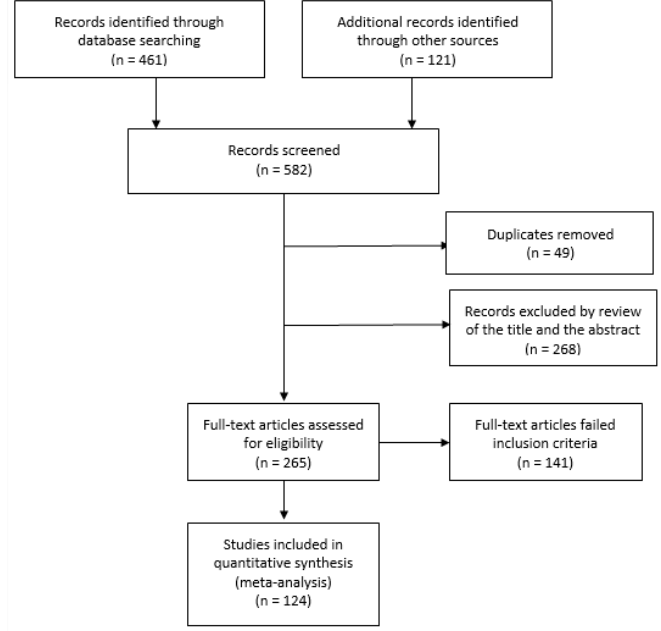
Figure 3. The flow diagram for studies included according to PRISMA.